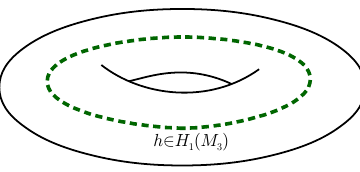
Figure 3 . Introducing a line operator labelled by h 2 H along a non-trivial cycle of the solid torus creates a state in H ( S 1 ) = C [ H T A [ M 3 ]